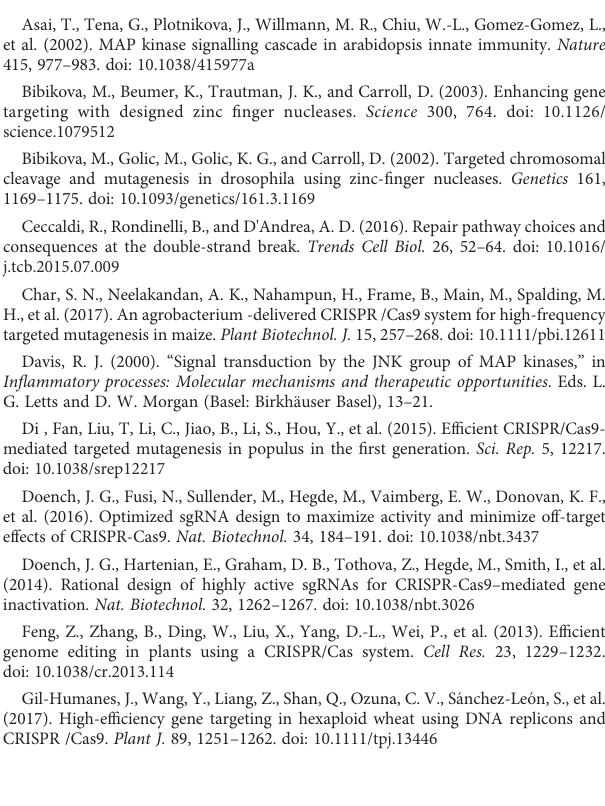
SUPPLEMENTARY FIGURE 2 Phylogenetic tree of Mitogen-activated protein kinase kinase 2; Bootstrap analysis was performed using 1,000 replicates to evaluate the reliability of the various phylogenetic groups. SUPPLEMENTARY FIGURE 3 The schematic fi gures of cassette backbone preparation SUPPLEMENTARY FIGURE 4 Theschematic fi gures ofhomologous arms andpDDT preparation for500 bp homology sequences SUPPLEMENTARY FIGURE 5 Mean comparison of regenerated and recovered events through different designed groups. SUPPLEMENTARY FIGURE 6 Therawdocumentusedinthisresearch. (A) 1457bpofrecombinantgenomic DNA has been ampli fi ed to prove the proper HDR happenings through recovered events isolated from nptII and MKK2 locus intron 2. (B) 1984 bp of ampli fi ed fragments selected from 2XCaMV35S and MKK2 locus intron 1. On-target and off-target activities are shown as the speci fi c and unspeci fi c bonds, respectively; CT was used as the control. NCT was used as the negative control. Yellow dashed lines indicate cut gels presented in . SUPPLEMENTARY FIGURE 7 Sanger sequences, alignment, and sequence analysis from recovered edited events reveal